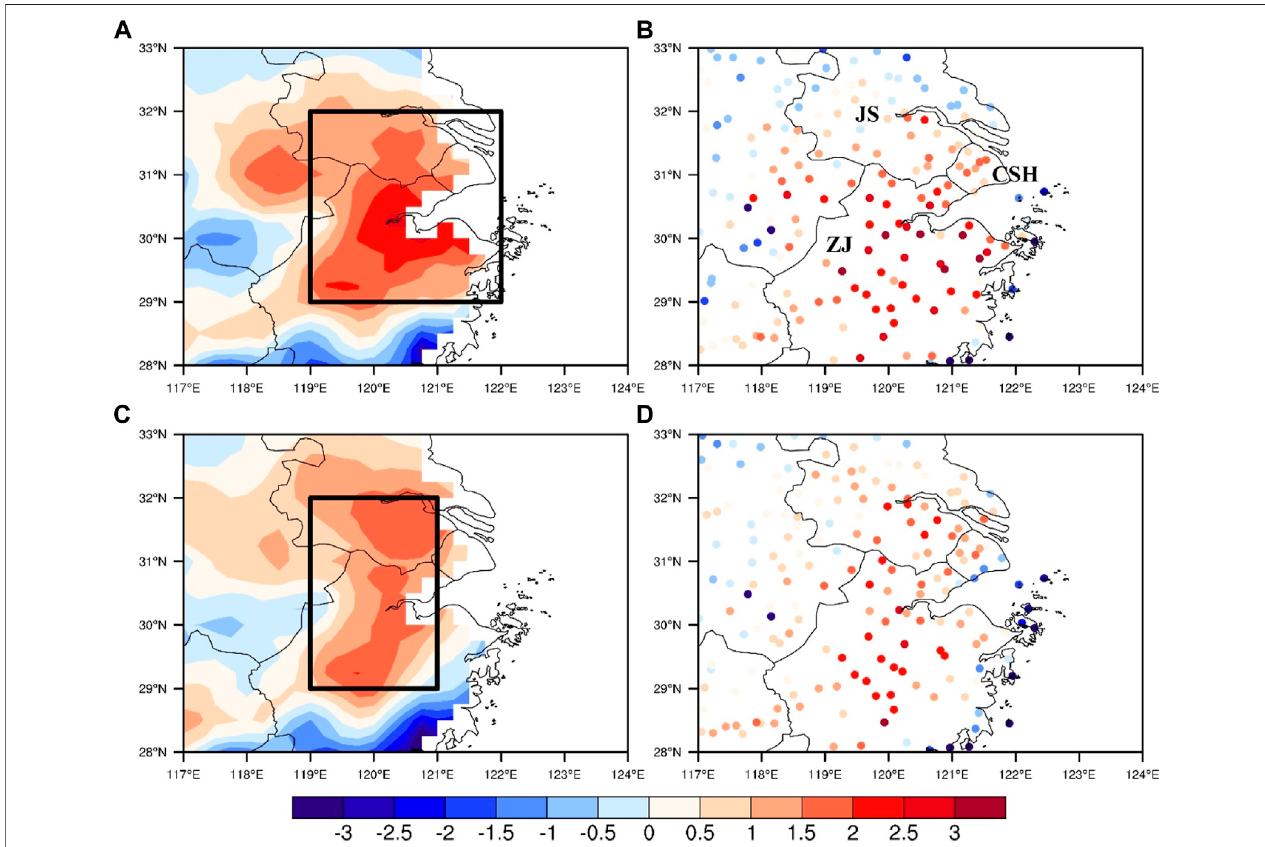
FIGURE2|(A) Observeddailymaximumairtemperature anomalies( ° C)ineasternChinaduringthe2013summerfor (A) CN05.1, (B) station-based observations. (C,D) Same as (A,B) , but for the summer of 2017. The abbreviations of CSH, JS, and ZJ in (B) stand for the city of Shanghai, Jiangsu and Zhejiang provinces. The outlined boxes in (A) and (C) depict the local areas for further regional